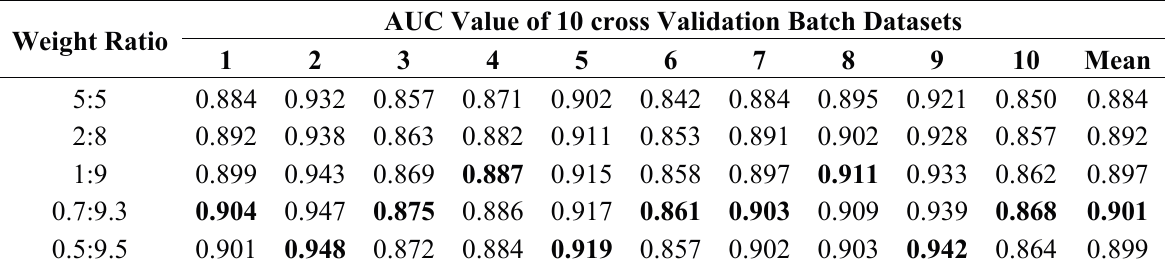
Table 3. AUC values of different combinations of weight ratio between order and disorder states on 10 cross validation batch datasets of Disorder723.